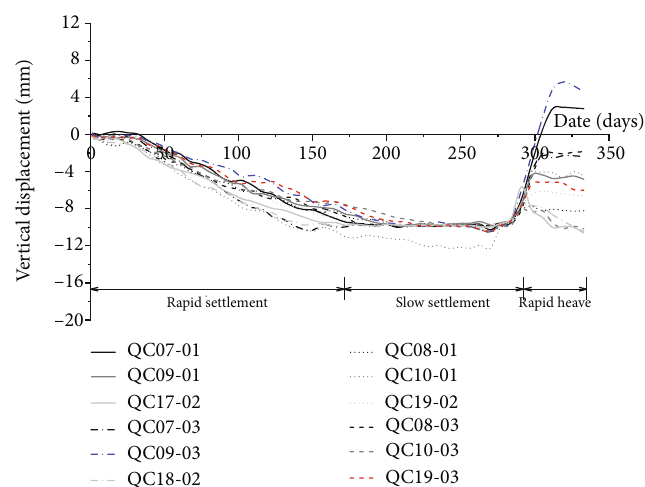
Figure 5: Time histories of vertical displacements of the end-suspended